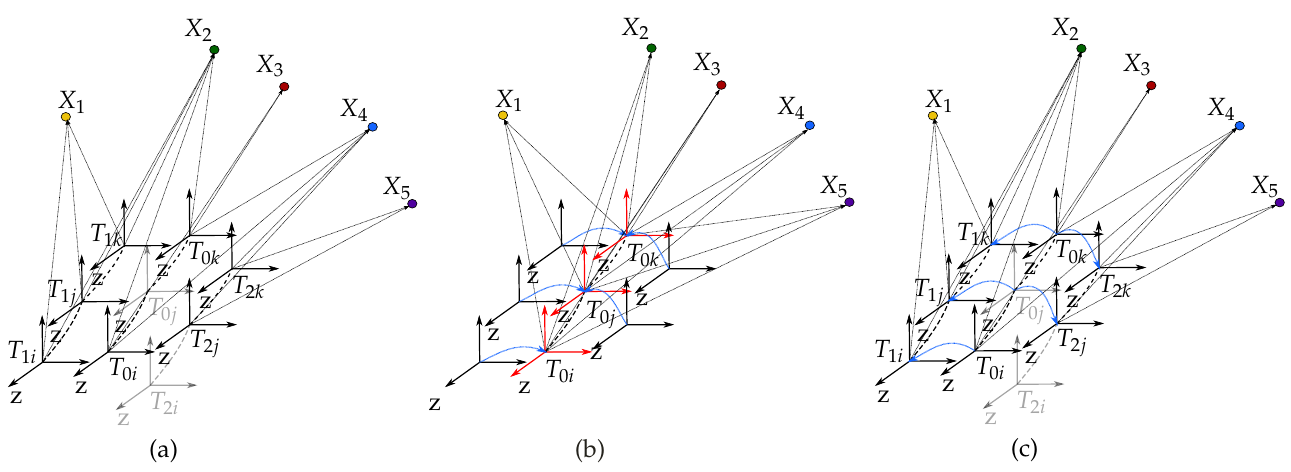
Figure 4. ( a ) The map with the keyframes and the map points before the optimization. Black coordinates represent the keyframes from multi-cameras while gray arrows indicate that there is no keyframe produced at the corresponding timestamp. ( b ) With the help of the extrinsic parameters between the reference camera and the nonreference cameras (blue), all the keyframes are transformed into the corresponding keyframes of the reference camera as if all the map points are observed from the reference camera. ( c ) All the keyframes, the map points, and the extrinsic parameters are optimized. After the optimization, the recovered keyframes of the nonreference cameras are transformed back to the original positions with the help of optimized extrinsic parameters